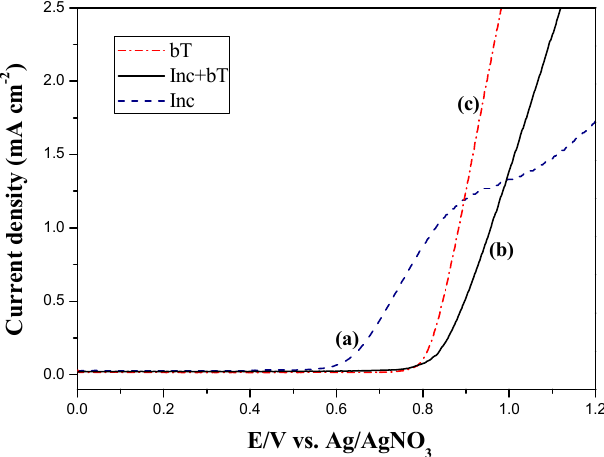
Figure 2. Anodic polarization curves of ( a ) 4 mM Inc., ( b ) 4 mM Inc. + 4 mM bT, and ( c ) 4 mM bT in PC+ACN solution containing 0.2 M LiClO 4 at a scan rate of 100 mV s − 1 .